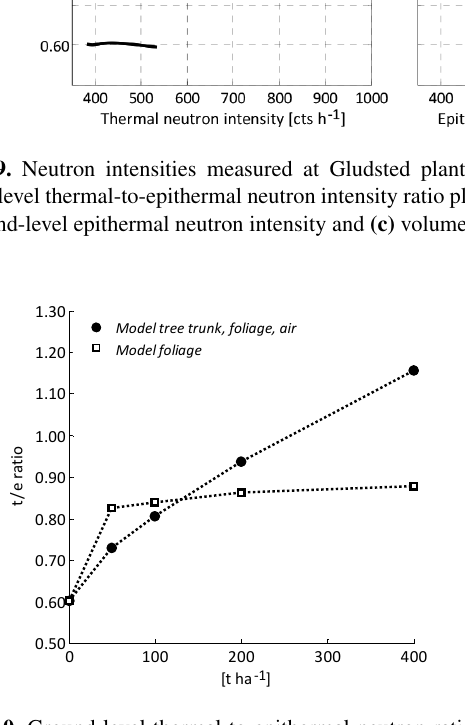
Figure 10. Ground-level thermal-to-epithermal neutron ratio plot- ted against biomass equivalent to dry aboveground biomass of 50, 100 (Gludsted plantation), 200 and 400tha − 1 using model tree trunk, foliage, air and model foliage,